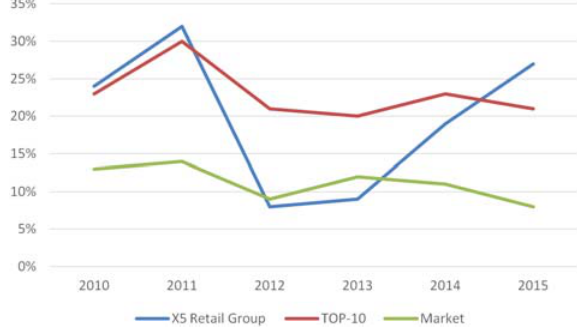
Fig. 4. X5 Retail Group VS Russian food retail in top-line